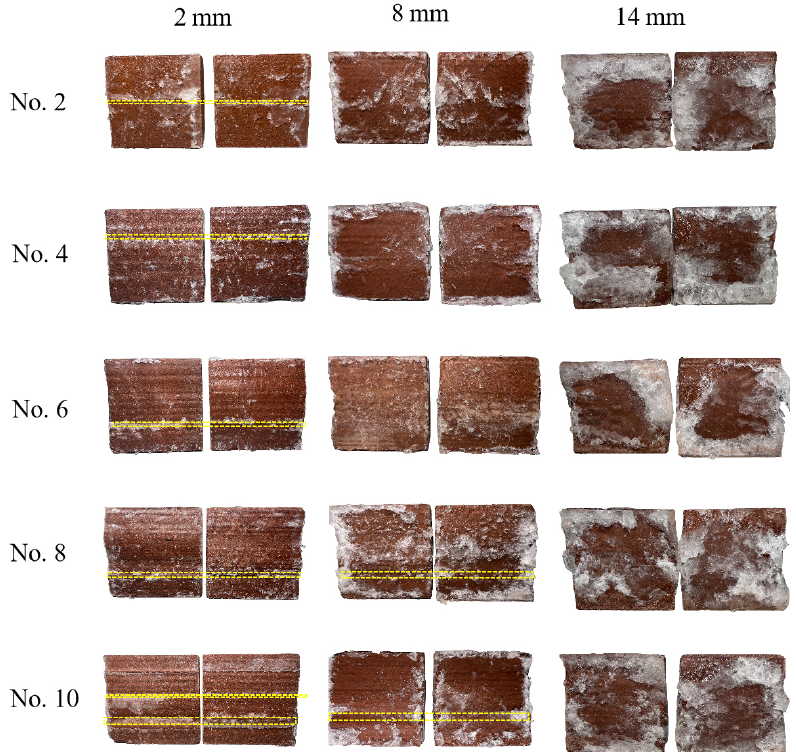
Figure 13. The shear rupture characteristics of ice-filled joints with different openings. Experimental conditions: T =− 5 ◦ C, d = 2mm and σ n = 0.5MPa. The yellow lines show the main aggregation of rupture ice. Ice after rupture aggregates in roughness bulges perpendicular to the shear direction. The aggregation phenomenon disappears as the joint openings increase. The aggregation phenomenon of profile no. 2, no. 4 and no. 6 disappears in 8mm joint openings. All profiles’ aggregation phenomena disappear in 14mm joint openings.